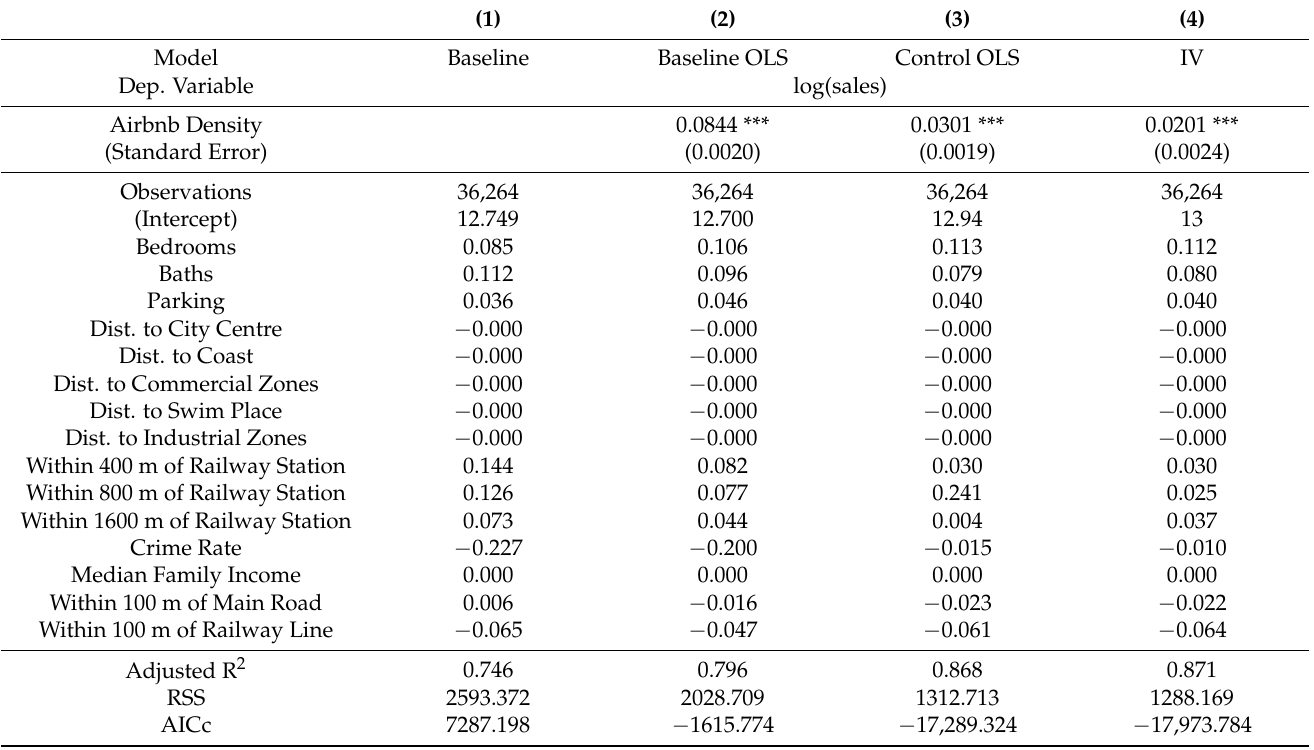
Table 2. Hedonic Modelling